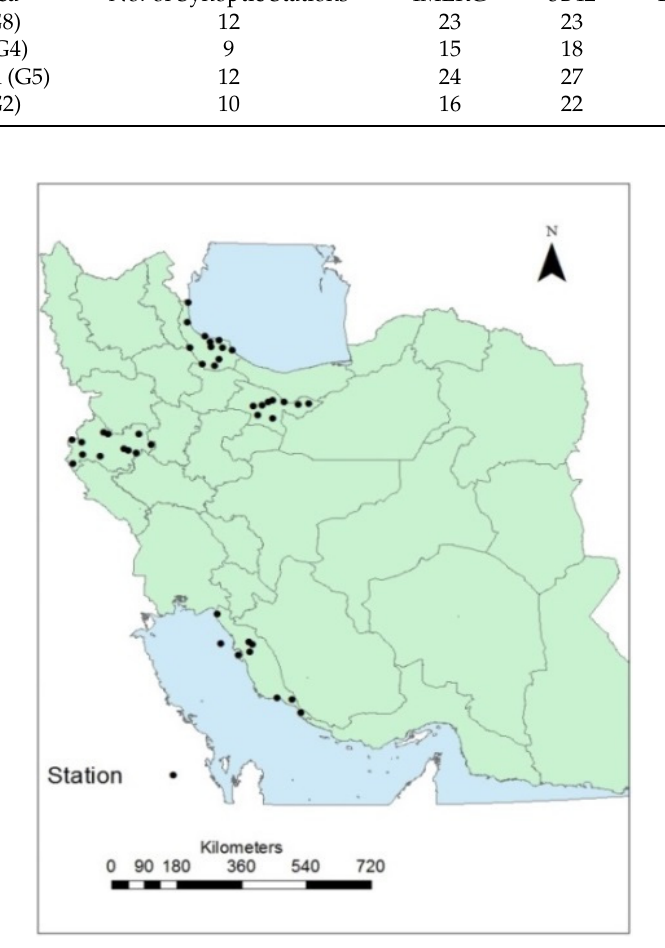
Figure 3. Map of meteorological synoptic stations.